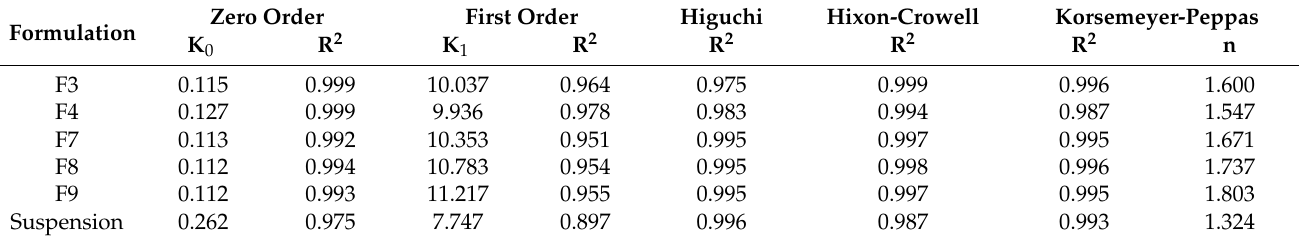
Table 5. The correlation coefficients and kinetics of APR release from SNEDDS and